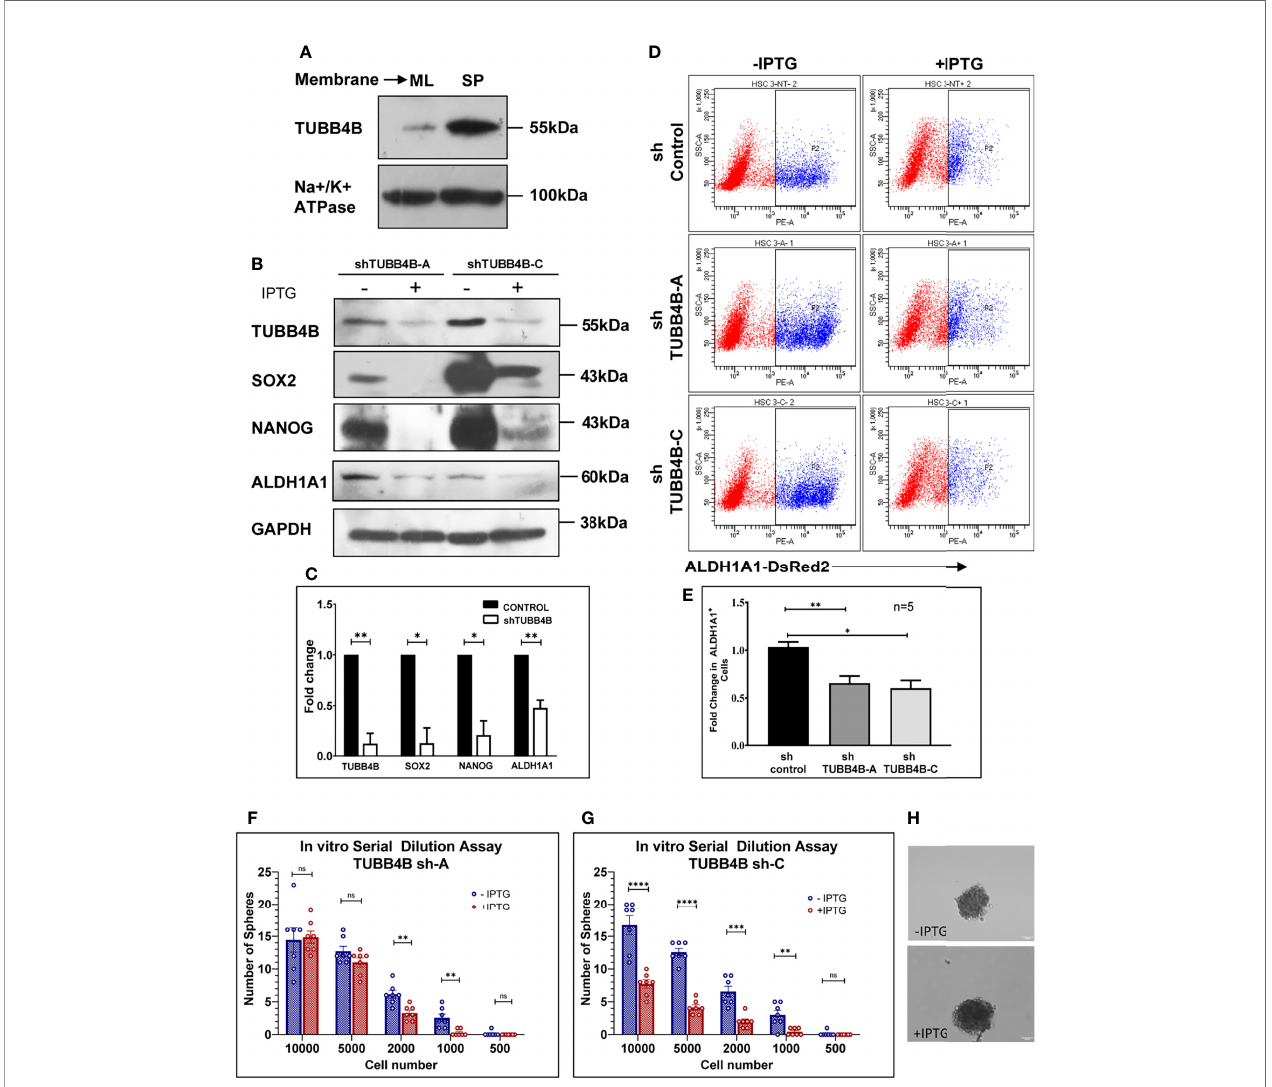
FIGURE 1 | TUBB4B supports CSCs. (A) Expression analysis of TUBB4B in the membrane fraction of monolayer (ML) and sphere culture (SP) of HSC-3 cell line by western blotting. (B) HSC-3 cells harboring an inducible shRNA (A or C) for TUBB4B were either treated or untreated with 50mM IPTG for six days for shRNA induction, and used for western blot assay of the indicated proteins. (C) shows the graphical representation of the normalized protein expressions. (D) HSC-3 cells stably expressing ALDH1A1-DsRed2, transduced either of the two TUBB4B shRNA lentiviral particles, or a non-target shRNA were used for the assay. The shRNA expressions were induced by administering 50mM IPTG for 10 days. Induced and uninduced cells were trypsinized, and DsRed2 expression was analyzed by FACS. Subpopulation P2 indicated high ALDH1A1 expressing (ALDH1A1 + ) cancer stem cells. The fold change of P2 subpopulation in the induced cells with respect to uninduced cells for the different shRNA groups were graphically represented (E) . Serial dilutions of TUBB4B shRNA induced and uninduced cells were plated in low adhesion plates in replicates and monitored for sphere formation for 10 days. (F, G) are the graphical representations of number of spheres formed using TUBB4B shRNA-A and C respectively. Representative images of spheres formed in induced and uninduced groups are also shown (H) . Scale bar is 100 m m. The error bars indicate SEM of biological replicates. ns represent non-signi fi cant data, * represents p < 0.05, ** represents p < 0.01, *** represents p < 0.001, and **** represents p <